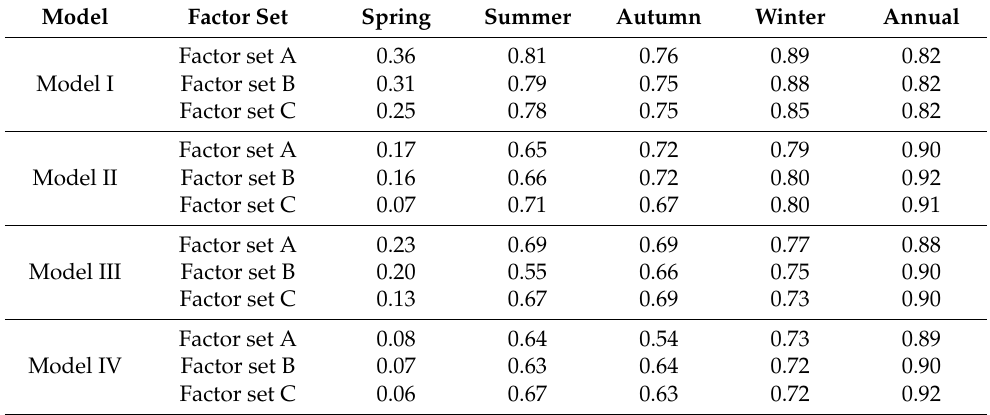
Table 3. R 2 values of the PM 2.5 concentration estimation model in the Chang-Zhu-Tan urban agglomeration. Model Factor Set Spring